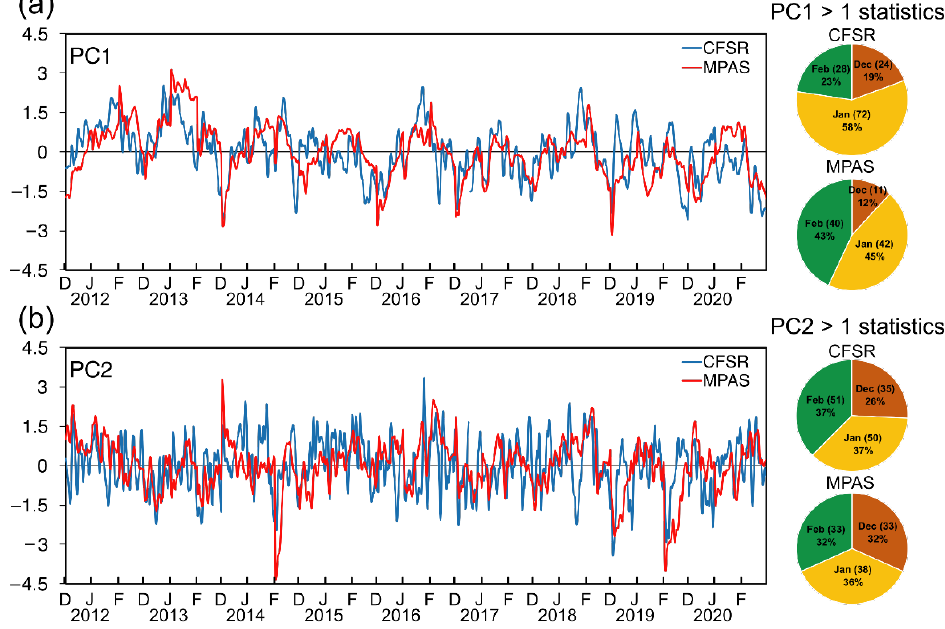
Figure 8. The normalized principal components of ( a ) the first EOF mode (PC1) and, ( b ) the second EOF mode (PC2) for CFS reanalysis (blue) and MPAS (red). The right column shows the observed and simulated days in December, January, and February for that PC1 and PC2 greater than 1.0 standard